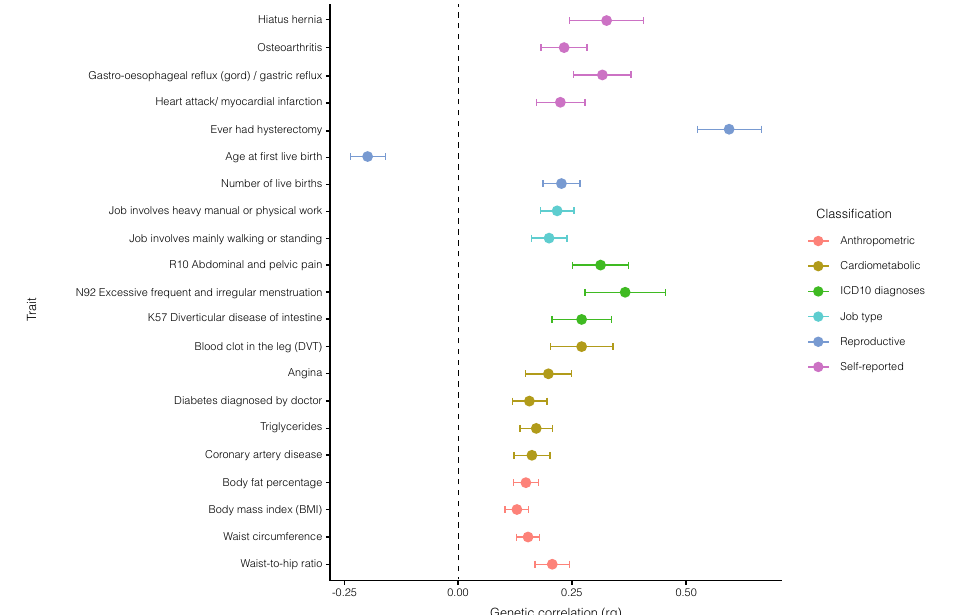
Fig. 3 Genetic correlation analyses. The genome-wide genetic correlation of POP GWAS meta-analysis summary statistics with 561 phenotypes was estimated using LDSC regression. Data is presented as means + − SEM. We accounted for multiple testing using a Bonferroni correction for 561 tests (0.05/561 = 8.91 × 10 − 5 ) and derived genetic correlation estimates (showed as circles). Phenotypes summary statistics come from published GWASs ( n = 43 phenotypes) and GWASs of UK Biobank data ( n = 518 phenotypes), available in LD-Hub v1.9.3. Signi fi cant genetic correlations showcased in the plot reveal overlap of genetic risk factors for POP across several groups of traits (grouped by colors): anthropometric (red dots; including body fat percentage ( n = 354,628), body mass index ( n = 354,831), waist circumference ( n = 360,564), waist-to-hip ratio ( n = 224,459), cardiometabolic (yellow dots; including blood clot in the leg (DVT) ( n = 7,386 cases and 353,141 controls), angina ( n = 11,372 cases and 349,048 controls), diabetes diagnosed by doctor ( n = 17,275 cases and 342,917 controls), triglycerides (mmol/L) ( n = 343,992), coronary artery disease ( n = 60,801 cases and 123,504 controls)), ICD10 diagnoses (green dots; including R10 Abdominal and pelvic pain ( n = 20,240 cases and 340,954 controls), N92 Excessive frequent and irregular menstruation ( n = 8,475 cases and 185,699 controls), K57 Diverticular disease of intestine ( n = 12,662 cases and 348,532 controls), job type (light blue dots; including Job involves heavy manual or physical work ( n = 205,000), Job involves mainly walking or standing, n = 204,956), reproductive traits (dark blue dots; including Ever had hysterectomy ( n = 13,973 cases and 157,440 controls), Age at fi rst live birth ( n = 131,987), Number of liver births ( n = 193,953)) and self-reported conditions (pink dots; including Hiatus hernia ( n = 32,590), Osteoarthritis ( n = 30,046 cases and 331,095 controls), Gastro-esophageal re fl ux ( n = 15,210 cases and 345,931 controls), Heart attack/myocardial infarction ( n = 8,239 cases and 352,902 controls)). Study source can be found in Supplementary Data 8. Center values show the estimated genetic correlation (rg), which is presented as a dot and error bars indicate 95% con fi dence limits. Dotted black line indicates no genetic correlation. ICD International Classi fi cations of Diseases 10th Revision, DVT Deep Venous Thrombosis.